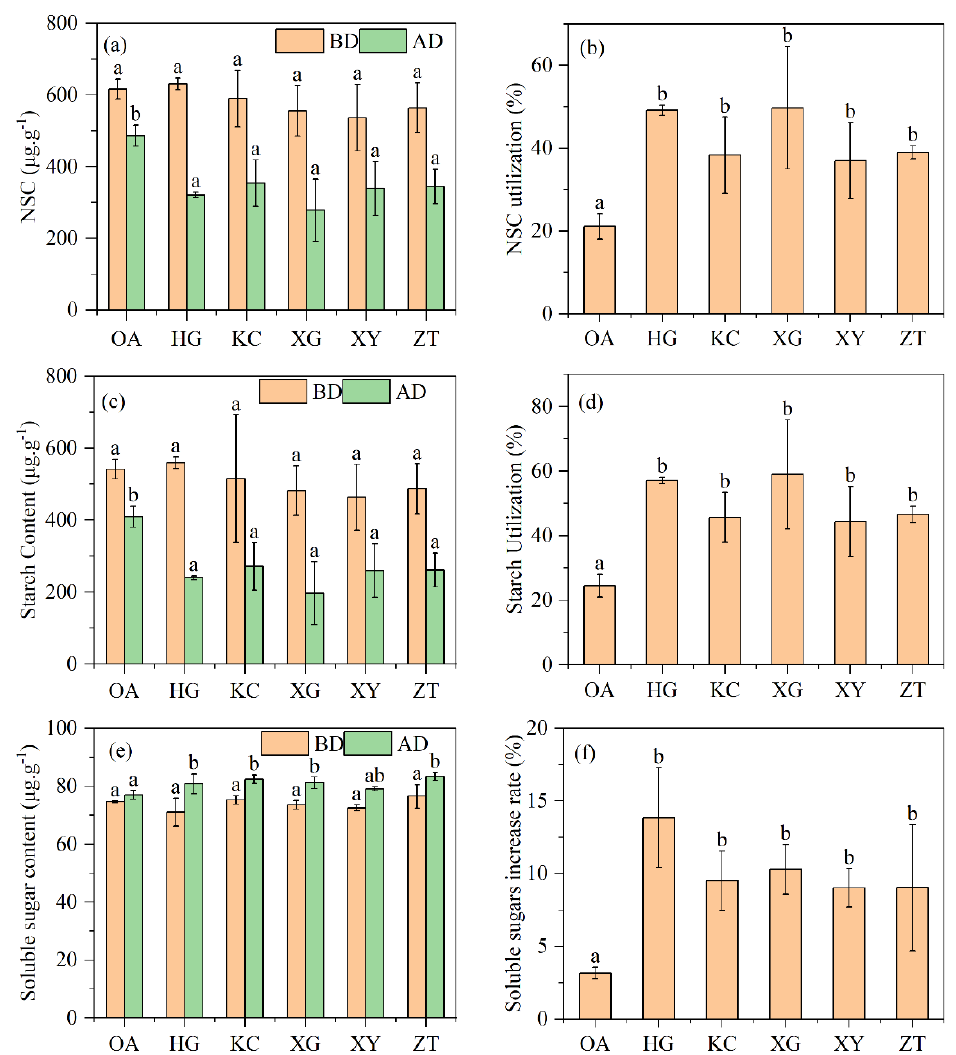
Figure 5. Total non-structural carbohydrates: ( a ) Non-structural carbohydrate utilization ( b ), starch content ( c ), starch utilization ( d ), soluble sugars content ( e ) and soluble sugars increment rate ( f ) of Qi-Nan and OA. Different letters denote significant ( p < 0.05) differences among OA and five Qi-Nan clones in a one-way ANOVA, the bar represents standard deviation ( n = 3), “NSC” non-structural carbohydrates; “BD” before drilling; “AD” after one and a half years of drilling.